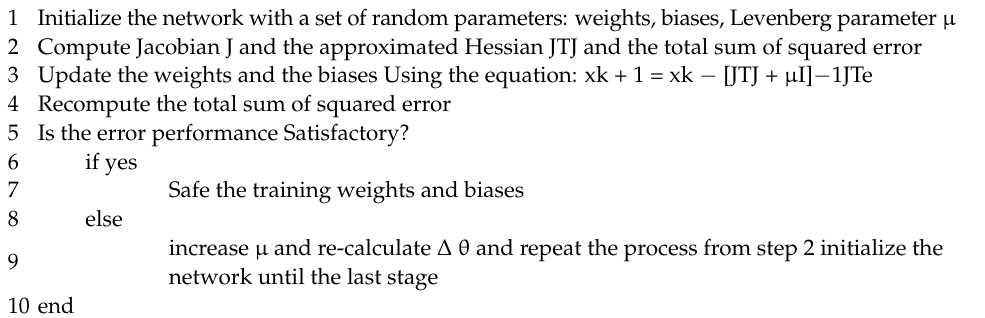
Algorithm 1: DLSA Optimization Method for Neural Network Training